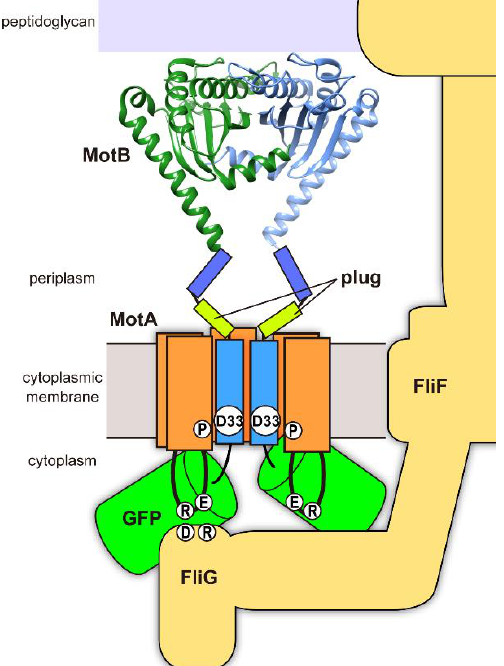
Figure 1. Schematic illustration of the MotA / GFP-MotB complex assembled into the flagellar motor. The N-terminus of MotB faces the cytoplasmic side. MotB-Asp33 (D33) and MotA-P173 (P) residues are located in the proton pathway and play important roles in the energy coupling mechanism of the flagellar motor. Highly charged Arg-90 (R) and Glu-98 (E) residues in the cytoplasmic loop of MotA interact with Asp-289 (D) and Arg-281 (R) of FliG. A plug segment of MotB (plug) suppresses proton leakage through the MotA / MotB complex. The ribbon diagram shows the crystal structure of the PGB domain of MotB (PDB ID: 2ZVY) forming a dimer; its dimerization is critical for the MotB function.